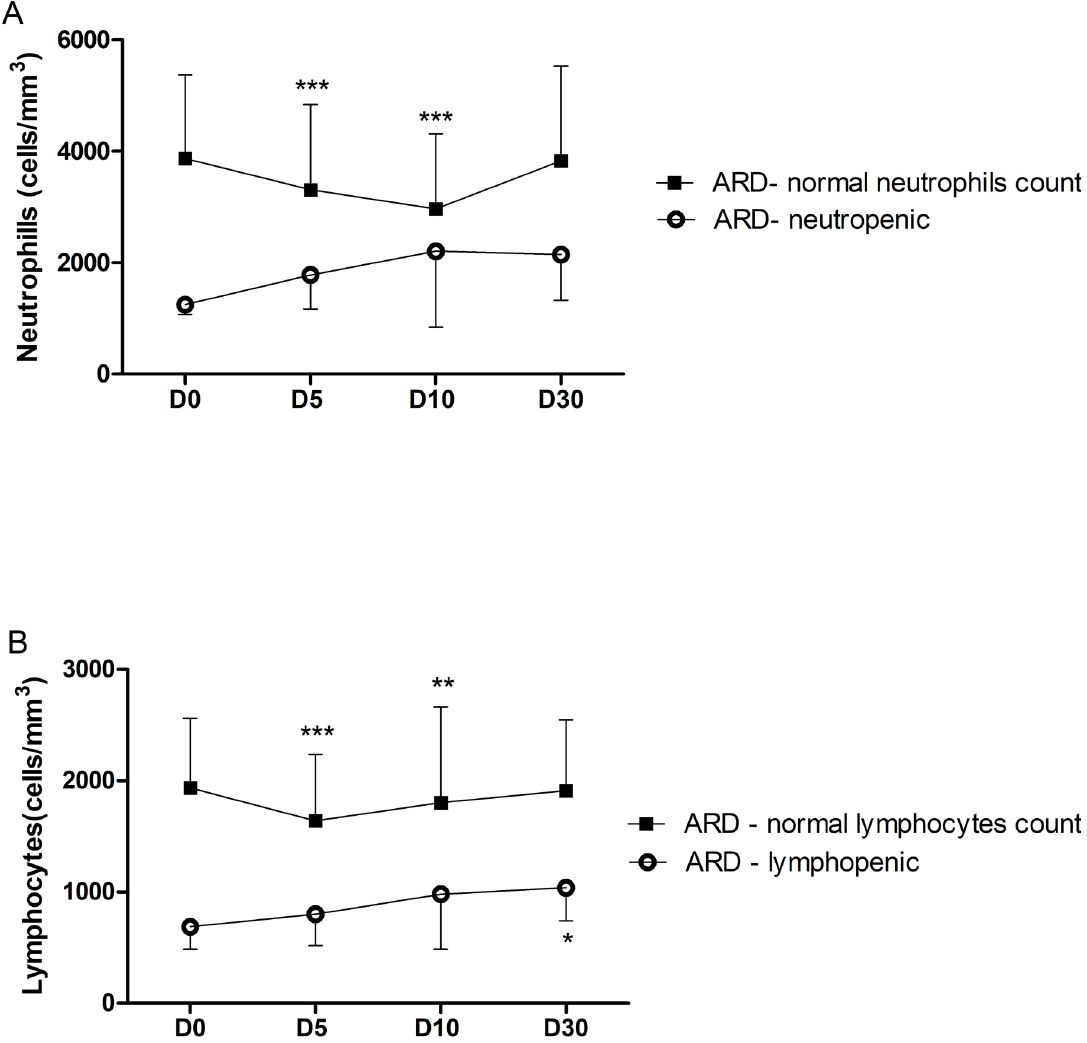
Fig 4. Longitudinal neutrophils(4A) and lymphocytes(4B) kinetics in ARD patients vaccinated for YF, comparing neutropenic vs. non-neutropenic and lymphopenic vs. non-lymphopenic patients. Values (cell/mm 3 ) represent the mean ± SD of measures for